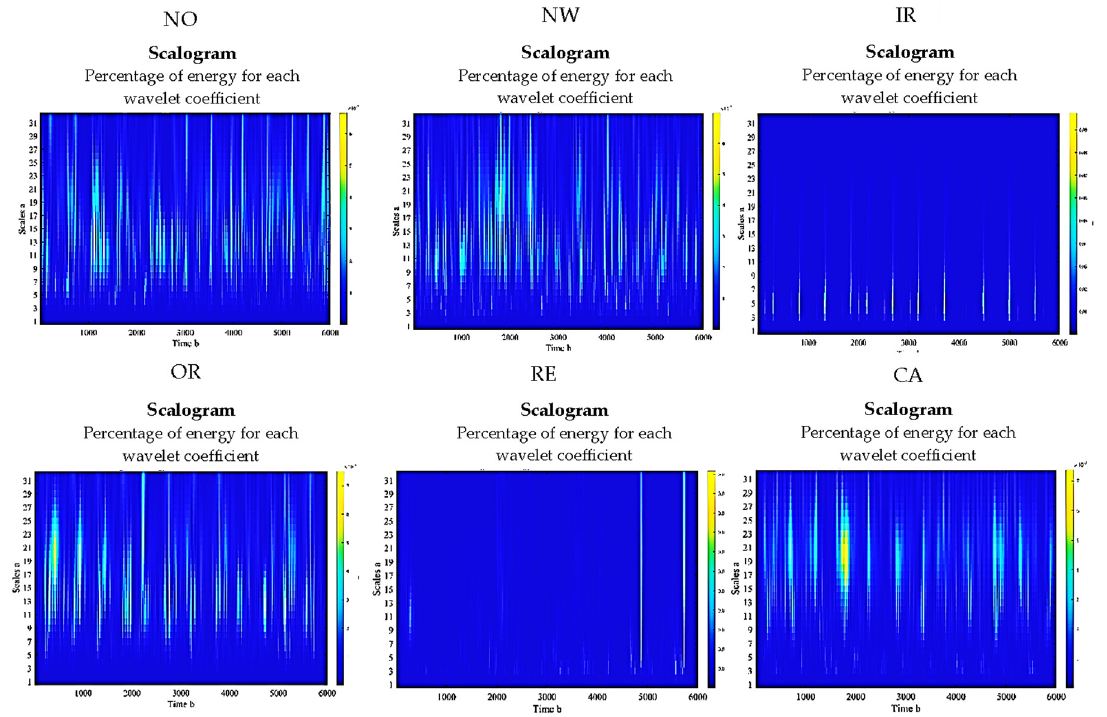
Figure 21. Examples of the produced scalograms using CWT with complex-valued Gaussian wavelets from bearing vibration signals with six health conditions that were described in Section 2.1.1